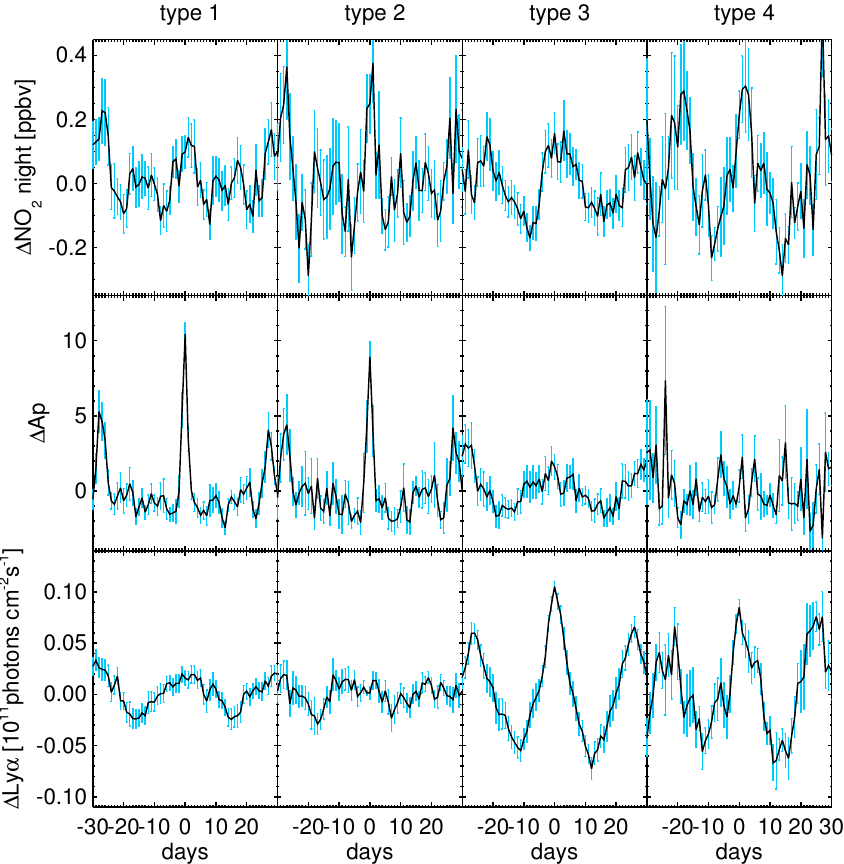
Fig. 2. SEAs of 103/34/96/21 (epoch types 1/2/3/4, respectively) different events in 2007–2011 at 50km altitude and 65 ± 5 ◦ N geomagnetic latitude. The columns define the epoch type number, the rows show ∆ NO 2 , ∆ Ap, and ∆ Ly- α . The blue error bars show the 1 σ range.